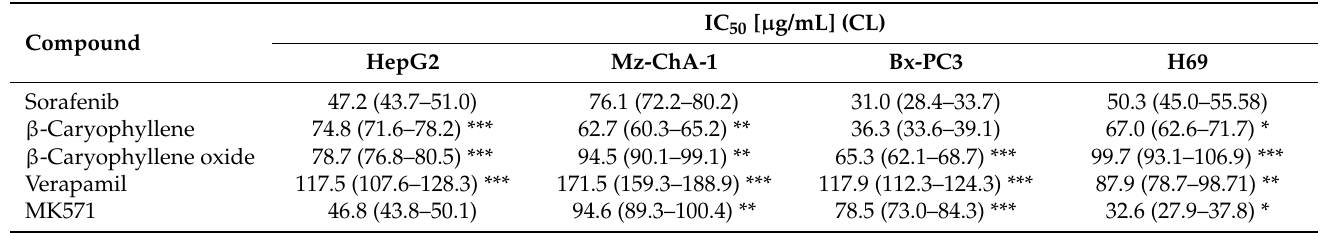
Table 2. IC 50 values of sorafenib, β -caryophyllene, β -caryophyllene oxide, and the positive controls verapamil and MK571 alone in hepatoblastoma (HepG2), extrahepatic cholangiocarcinoma